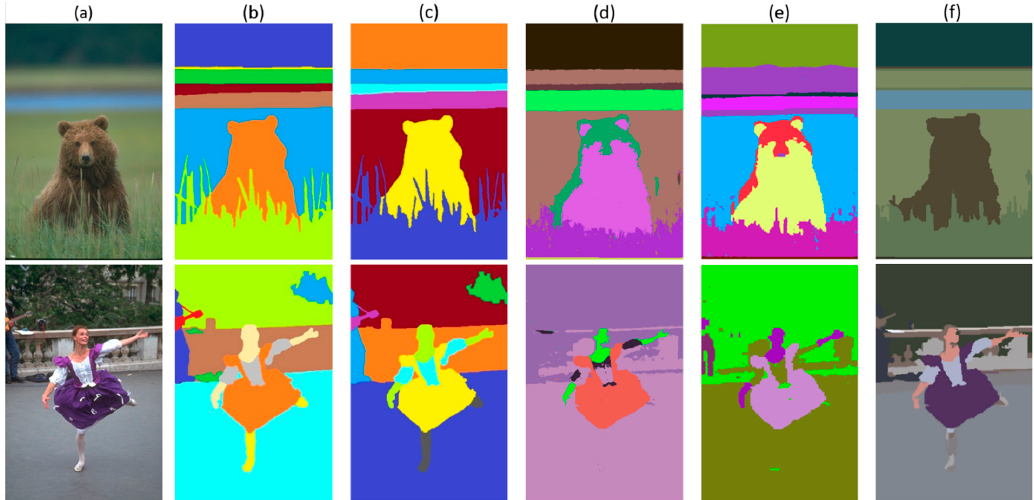
Figure 6. From left to right: ( a ) Original images, ( b ) and ( c ) ground truths provided by different annotators, ( d ) and ( e ) segmentation results of algorithm of [42] with Felzenswalb and SLIC respectively, ( f ) segmentation results of proposed algorithm.